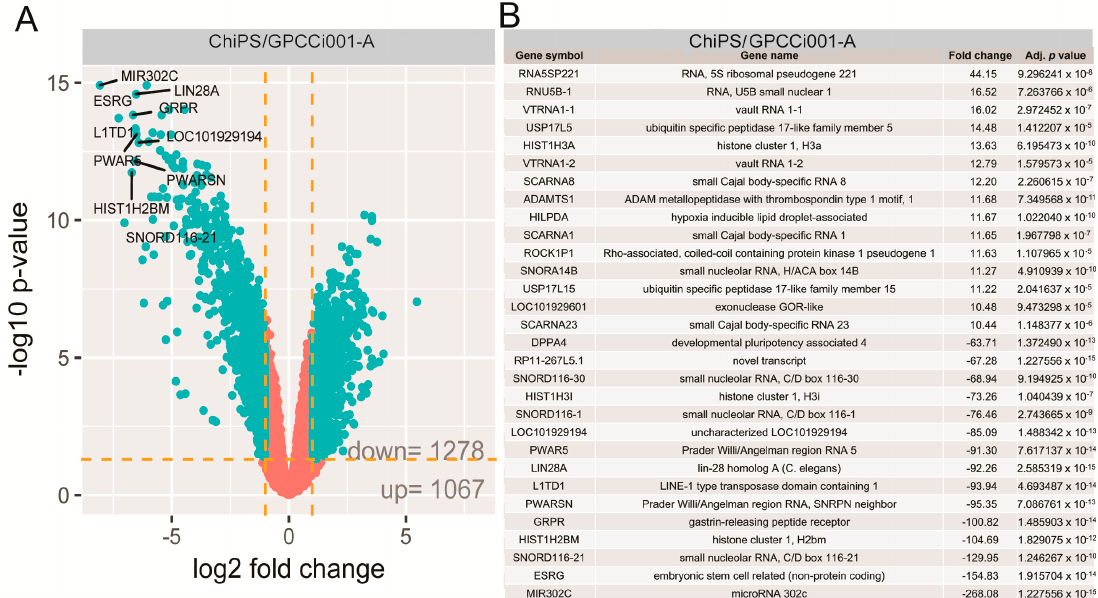
Figure 3. Volcano plots show the total gene expression profiles of the ChiPS and GPCCi001-A experimental groups. Each dot represents the mean expression level ( n = 3) of a single gene obtained from a microarray normalized dataset. The orange dotted lines (cut off values) were established according to the following parameters: fold > |2| and adjusted p -value < 0.05. Genes above the cut-off are considered to be differentially expressed and are shown as blue dots. The total number of differentially expressed genes are displayed in the bottom right corner of the graph. The top ten most up- and down-regulated genes are described by their gene symbols ( A ). The table shows the 30 genes with the highest (15 genes) and lowest (15 genes) fold changes obtained from the list of differentially expressed genes ( B ).